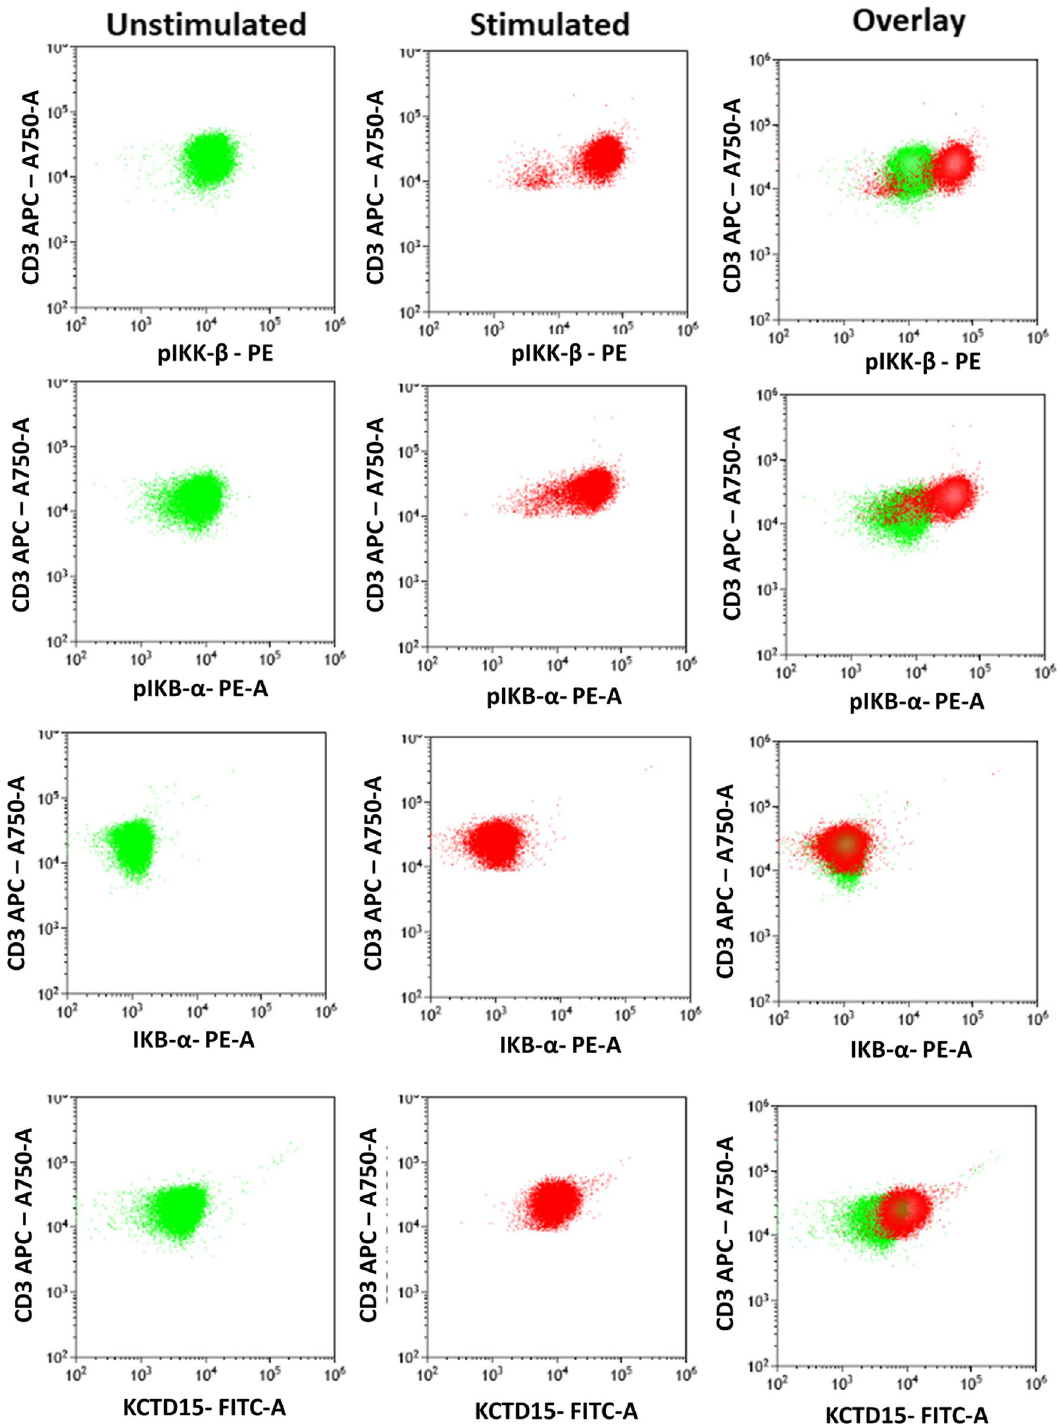
Figure 4. Stimulation of circulating lymphocytes with PMA/Ionomycin is associated to KCTD15 upregulation. Overlay dot-plot showing the higher levels of pIKK, pIKB-α, and KCTD15 in PMA/Ionomycin activated lymphocytes (red) compared to unstimulated lymphocytes (green). IKB-α protein remains unchanged. Results are representative of two independent